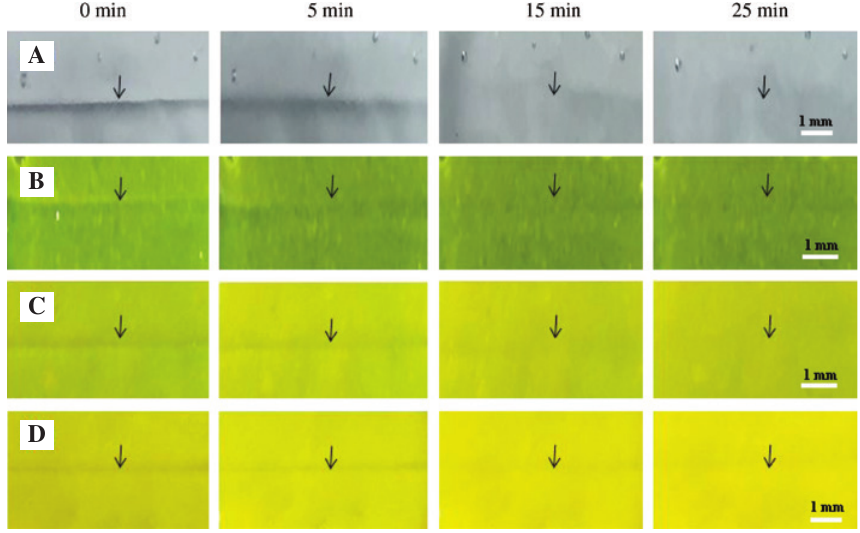
/PDMS-urea composite films with different perovskite QDs loading. 3 (0.4 wt.%)/PDMS-urea; (C) MAPbBr (0.8 wt.%)/PDMS-urea and (D) MAPbBr 3 3